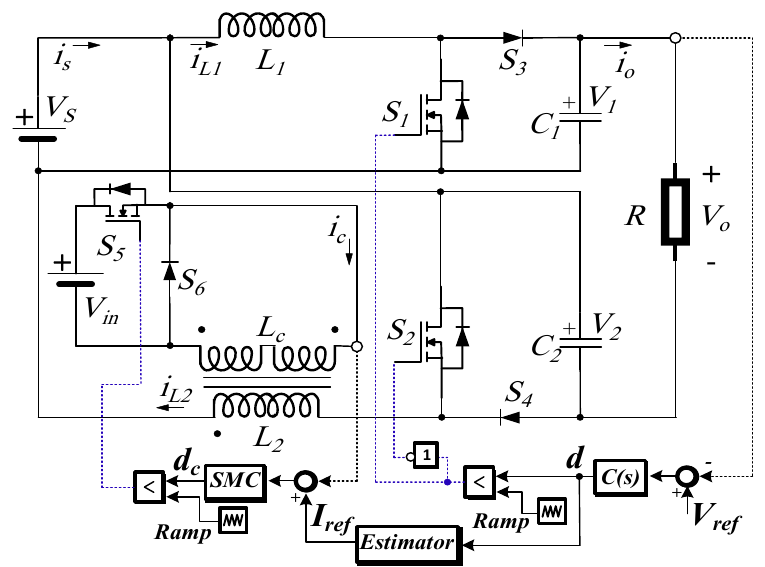
Figure 1. Schematic diagram of FIBC with a VI and its control structure.